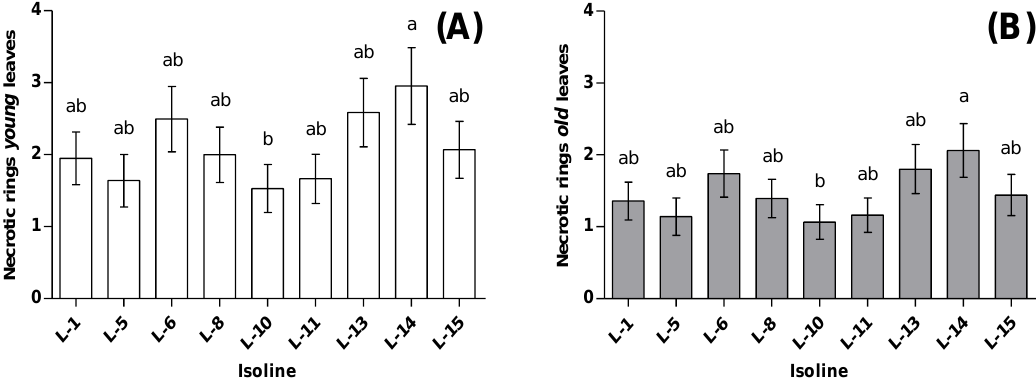
Figure 1. Average necrotic rings inflicted by N. tenuis on tomato plants. ( A ) Average necrotic rings in ‘young’ leaves, ( B ) Average necrotic rings in ‘old’ leaves. Bars sharing letters are not significantly different; error bars represent SE.